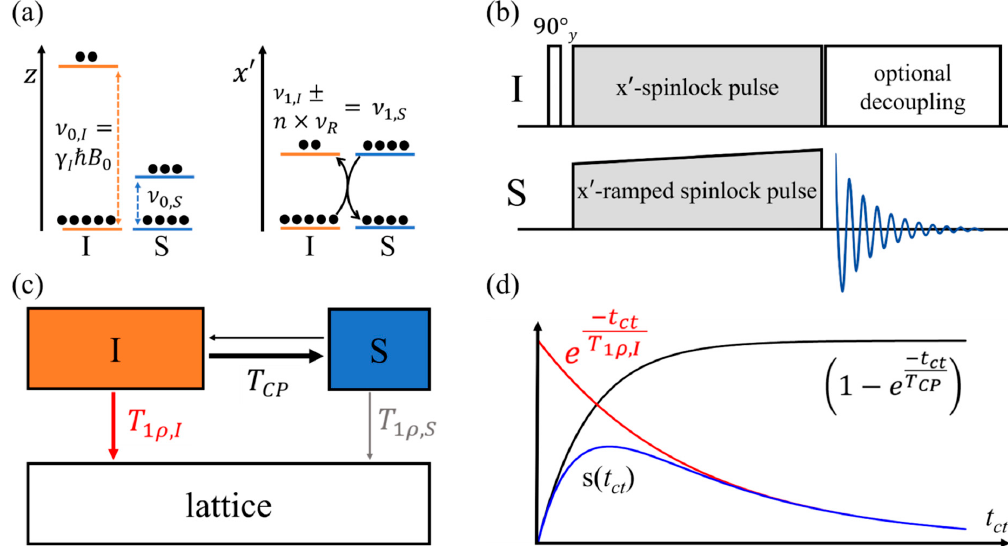
Figure 14. Principle of the cross-polarization (CP) NMR experiment: ( a ) Zeeman states for an I (orange) and an S nucleus (blue) along the quantization axis, split by the external magnetic field (left) and by the magnetic component B 1 of the applied radiofrequency field under spin-lock conditions. Here, full circles illustrate population di ff erences. ( b ) Pulse sequence timing diagram. During the spin-lock time, the nutation frequency of one of the nuclear species is ramped to account for modulation e ff ects in the Hartmann–Hahn matching condition caused by MAS. ( c ) Competitive cross-relaxation and rotating frame spin-lattice relaxation processes. ( d ) Signal intensity as a function of contact time resulting from these competitive